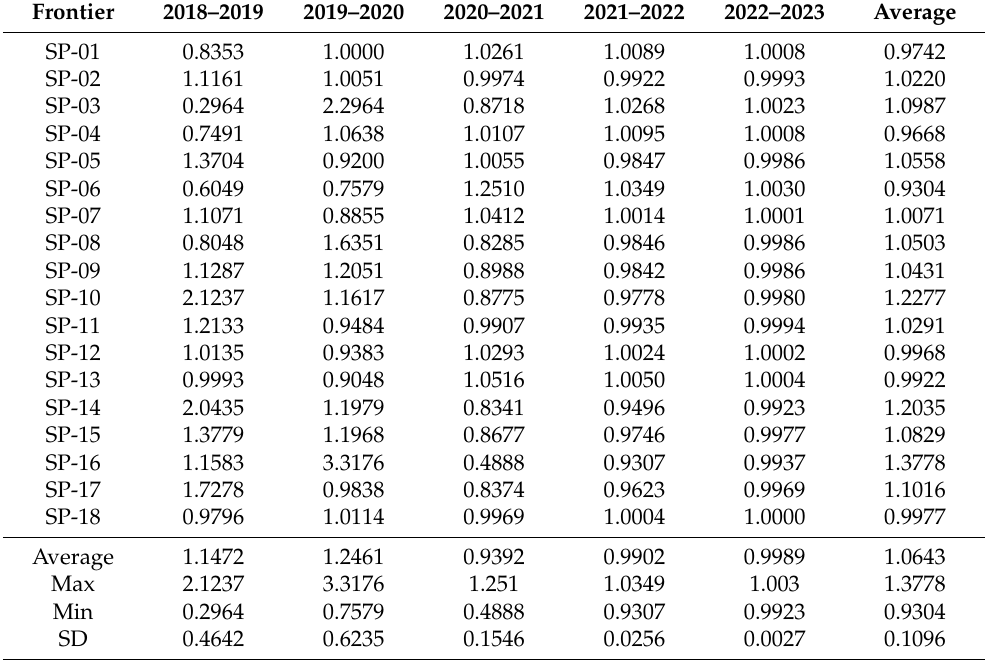
Table 9. Total productivity change for the period 2018–2023.